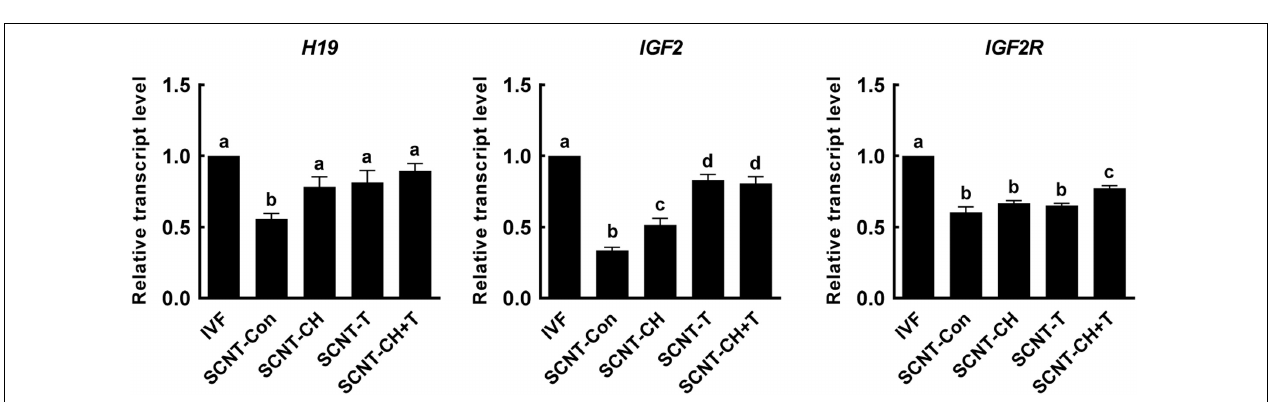
FIGURE 6 | Effects of chaetocin, TSA, and the combination on the ZGA in porcine SCNT embryos. The data are from three independent experiments and are means ± SEM. Values with different superscripts differ significantly ( P < 0.05). IVF, in vitro fertilization; SCNT, somatic cell nuclear transfer; Con, control; CH, chaetocin; T, TSA.